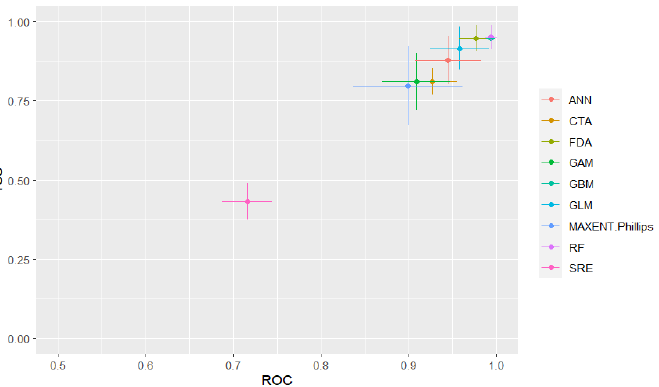
Figure 3. Two accuracy statistics (TSS and ROC) for 10 ecological niche models and the ensemble model.